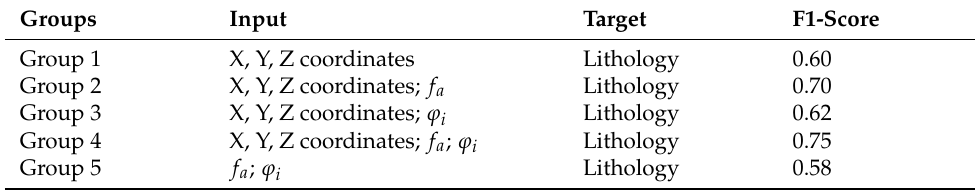
Table 5. Classification results of the different input